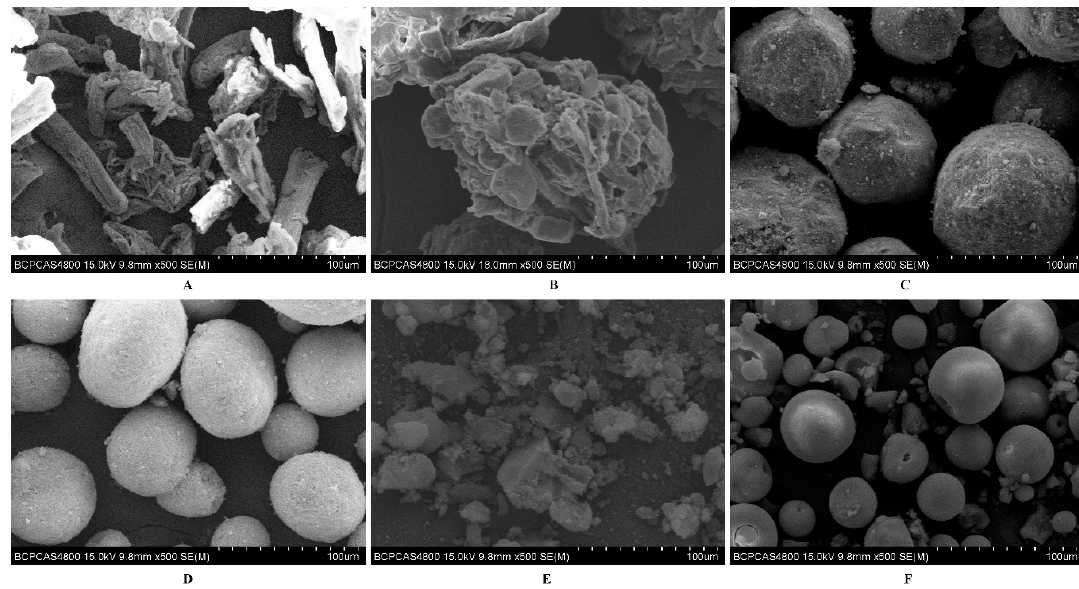
Figure 7. SEM micrographs of various solid adsorbents. ( A ) Vivapur ® PH102; ( B ) Cellatose ® 80; ( C ) Fujicalin ® ; ( D ) Neusilin ® US2; ( E ) Cab-O-Sil ® M5P; and ( F ) Aeroperl ® 300.